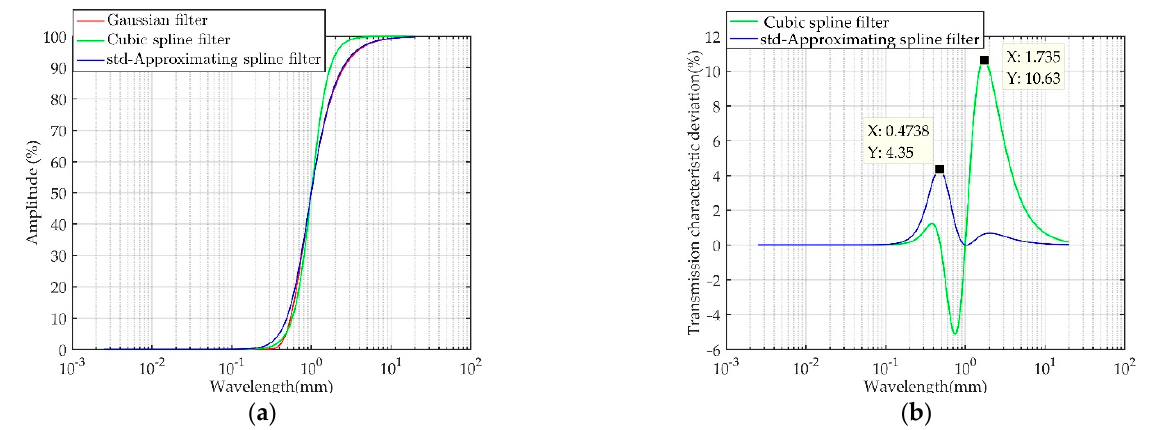
Figure 1. ( a ) Transmission characteristics and ( b ) transmission characteristic deviation of the Gaussian filter, and cubic spline filter, and std-approximating spline filter.